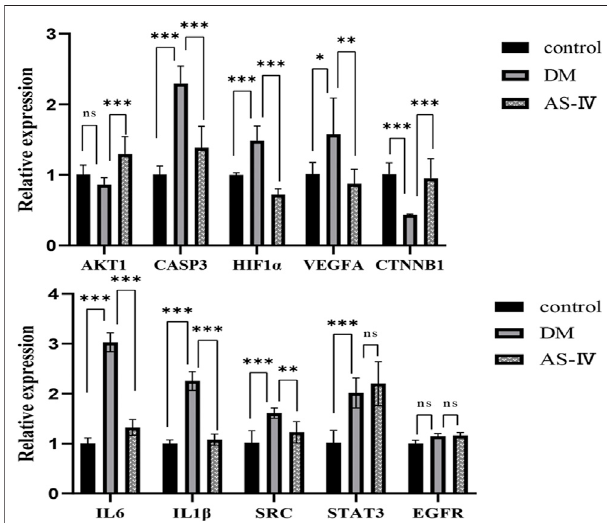
FIGURE7 | Expression changes of10core targets. DM,diabeticgroup; AS-IV, treatment group. DM, diabetes mellitus; AS-IV, astragaloside IV. Data were presented as mean ± SD, * p < 0.05, ** p < 0.01, *** p < 0.001.